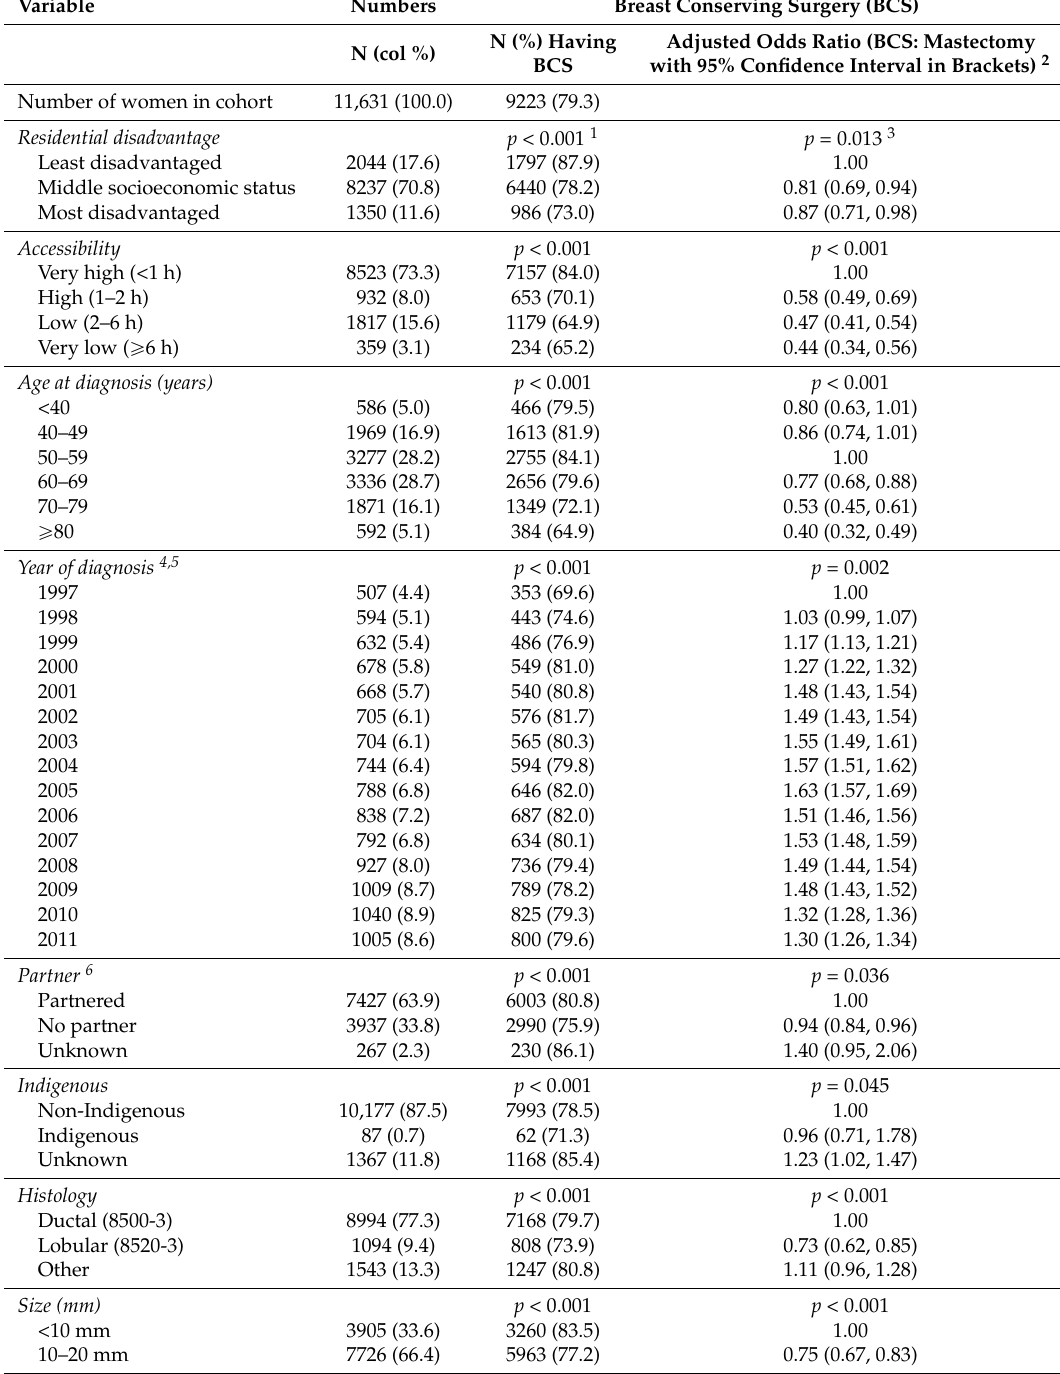
Table 1. Cohort of women with a first primary localised breast cancer, Queensland 1997–2011 having breast conserving